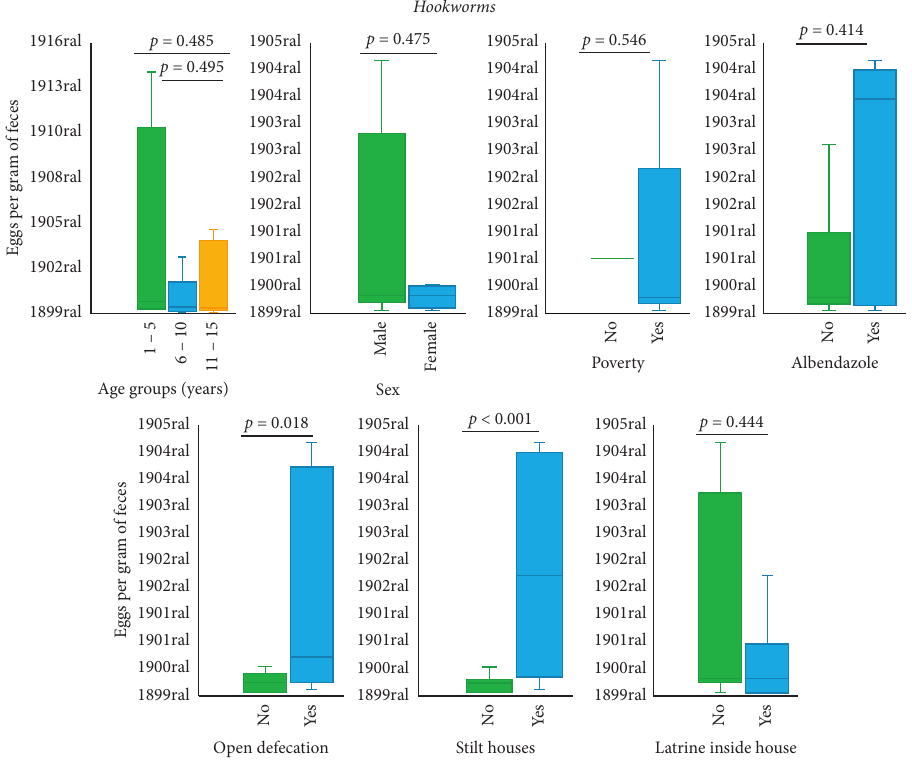
Figure 3: Boxplots depicting the comparisons of median and interquartile ranges of faecal soil-transmitted helminths egg counts in distinct groups defined by demographic and socioenvironmental characteristics. Comparisons were performed through the Mann–Whitney nonparametric